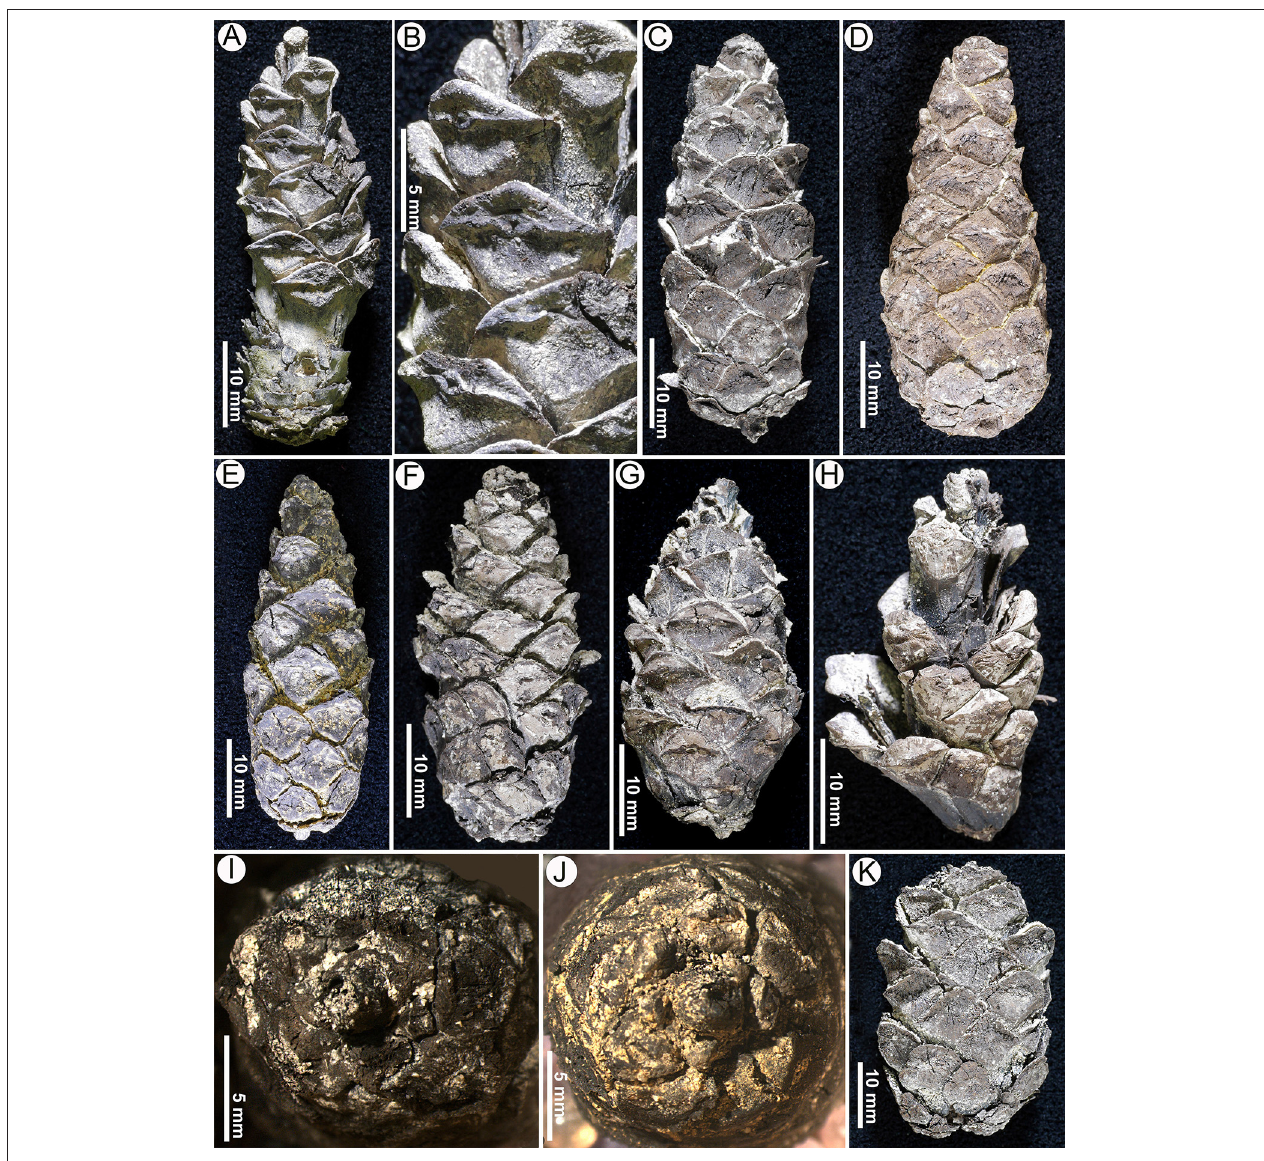
FIGURE 2 | Seed cones of Pinus prehwangshanensis sp. nov. (A) Specimen MMRH186. (B) An enlargement in (A) showing the apophyses with perexcentromucronate umbo. (C) Specimen MMRH169. (D) Holotype, specimen MMRH170. (E) Specimen MMRH181. (F) Specimen MMRH174. (G) Specimen MMRH182. (H) An upper part of dehiscent seed cone, specimen MMRH171. (I) A seed cone base, specimen MMRH169. (J) A seed cone base, specimen MMRH181. (K) Specimen MMRH168.